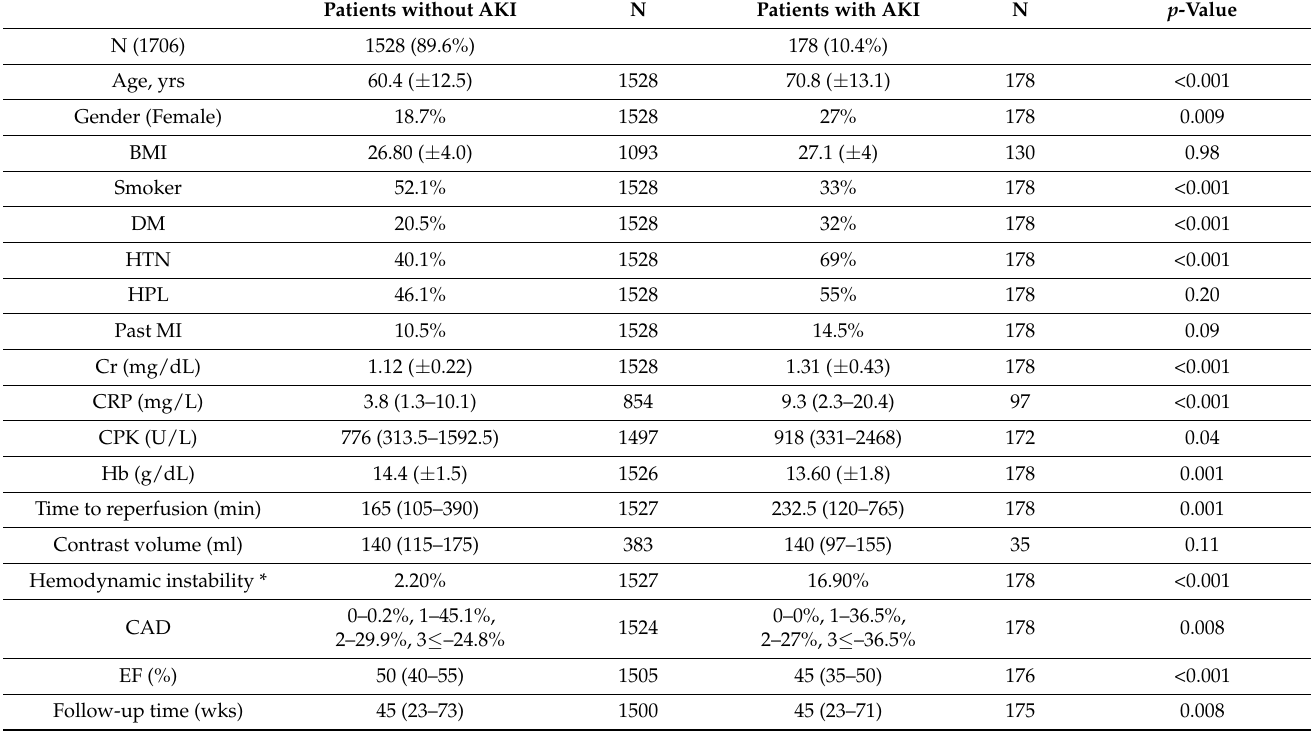
Table 1. Baseline characteristics of patients who suffered and did not suffer from